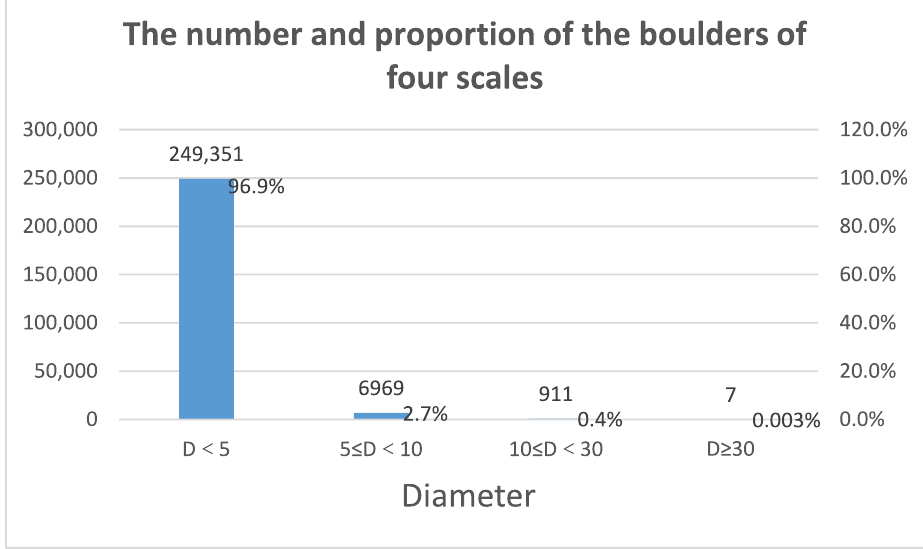
Figure 5. The number and proportion of the boulders of different